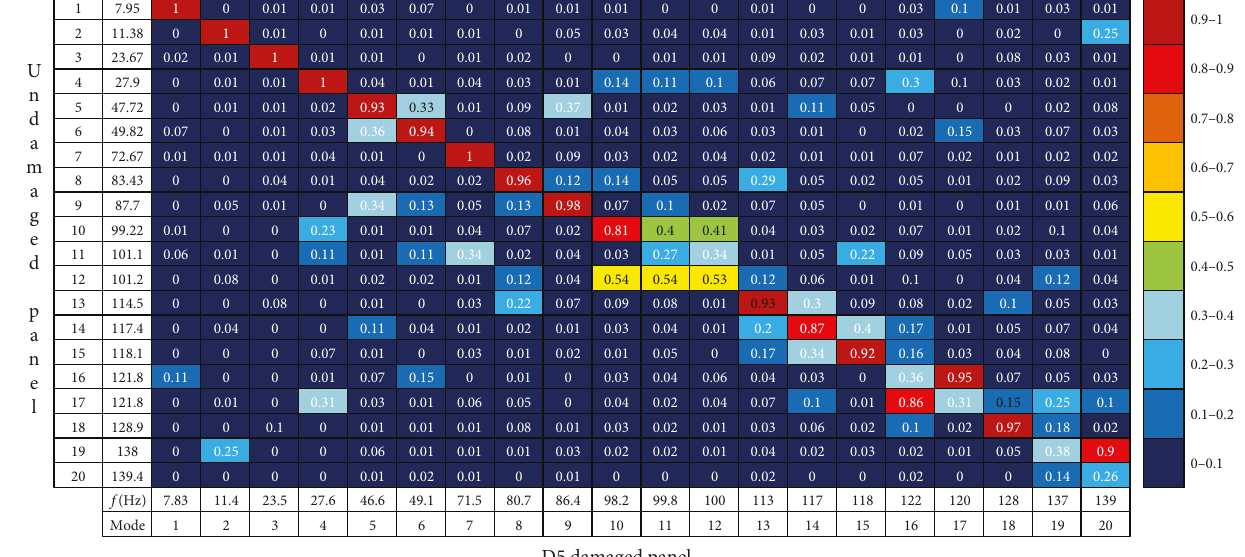
Figure 16: Undamaged panel – D5 damaged panel MAC.